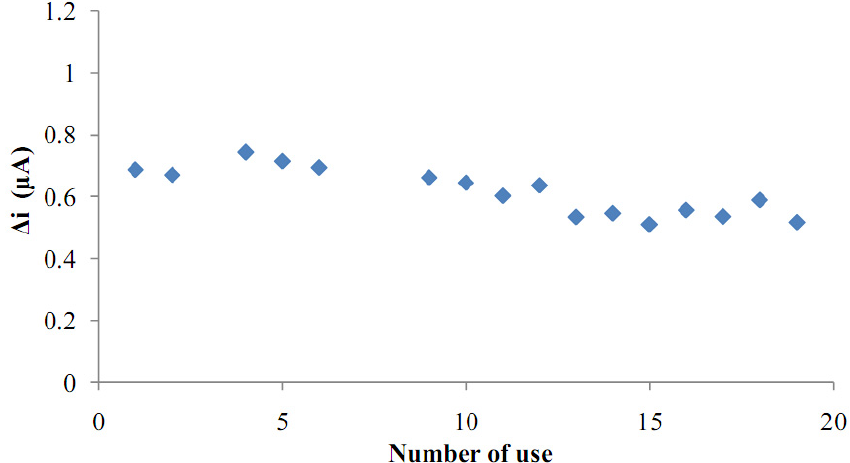
Figure 10. Operational stability of the biosensor in pH 7.5 phosphate buffer, at a 0.4 V operating potential, 25 °C.